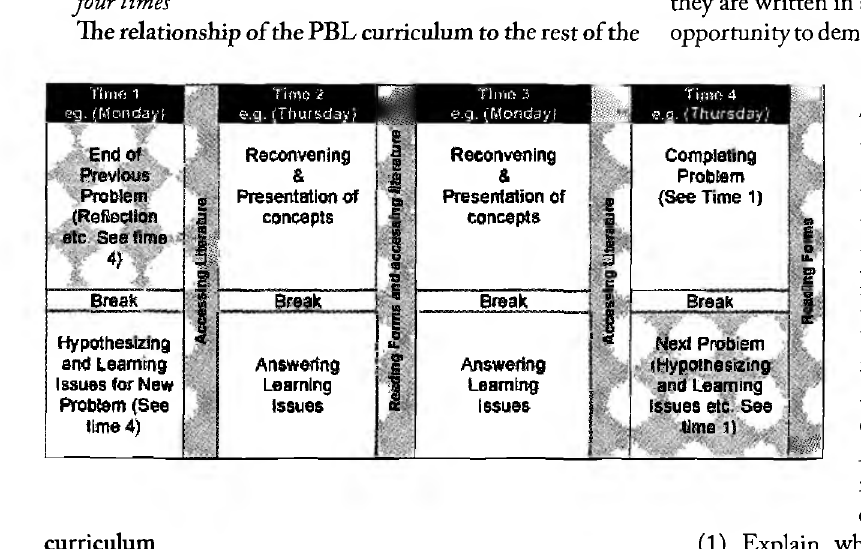
Table 1. A visual representation of tutorials structured over four times The relationship of the PBL curriculum to the rest of